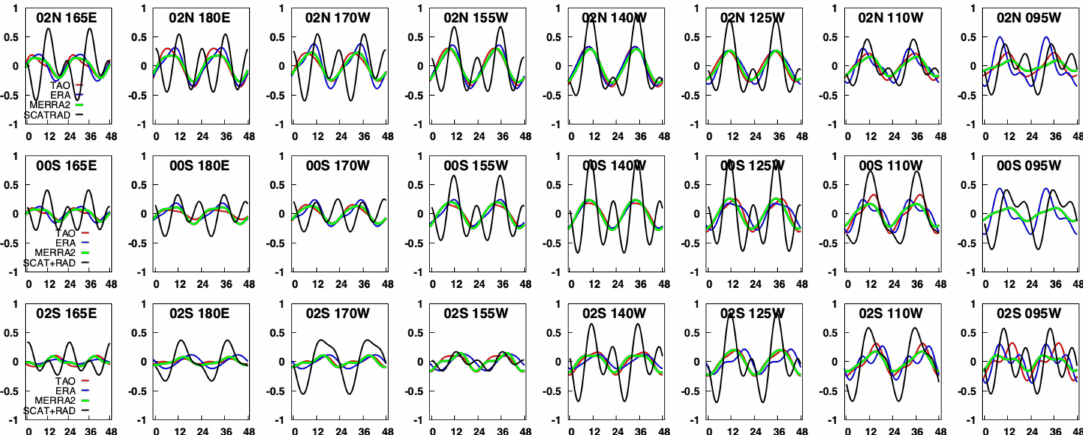
Figure 9. Same as Figure 8, but for meridional ( v ) wind component. Positive (negative) values indicate southerly (northerly) winds relative to the daily mean. The estimates from the TAO moorings, ERA-I, MERRA2 and the scatterometer + radiometer (SCAT + RAD) analysis are represented by the red, blue, green and black line colors,